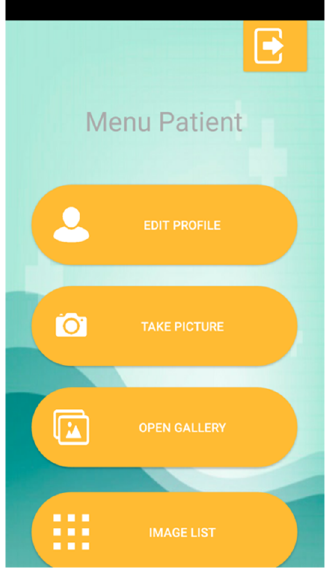
Figure 6. Patient’s Menu.